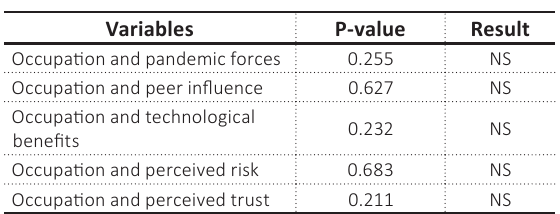
Table 7. Difference between occupation